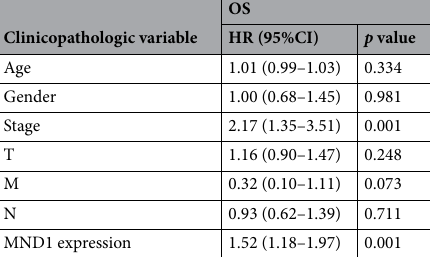
Table 4. Multivariate survival model after variable selection.